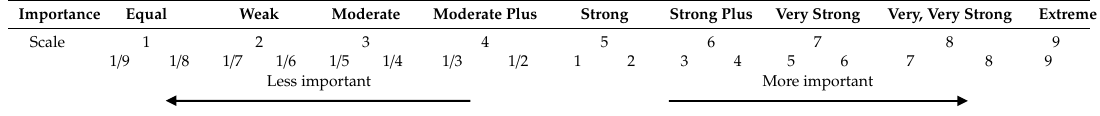
Table 2. Analytic Hierarchy Process (AHP) relative class rate scale according to Saaty [58].